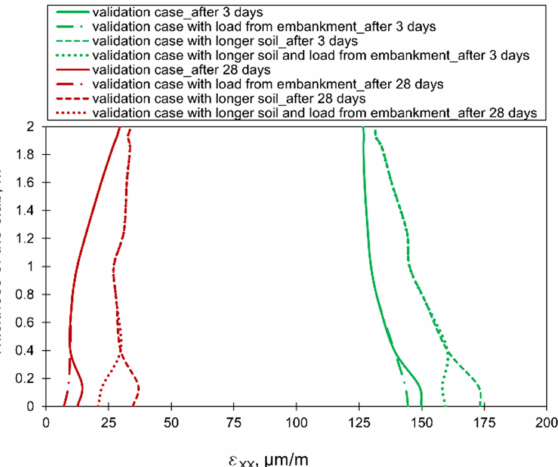
Figure 16. The effect of the different sizes of FE at the thickness of the slabs on the developments of stress σ xx with thicknesses of ( a ) 2 m and ( b ) 4 m.